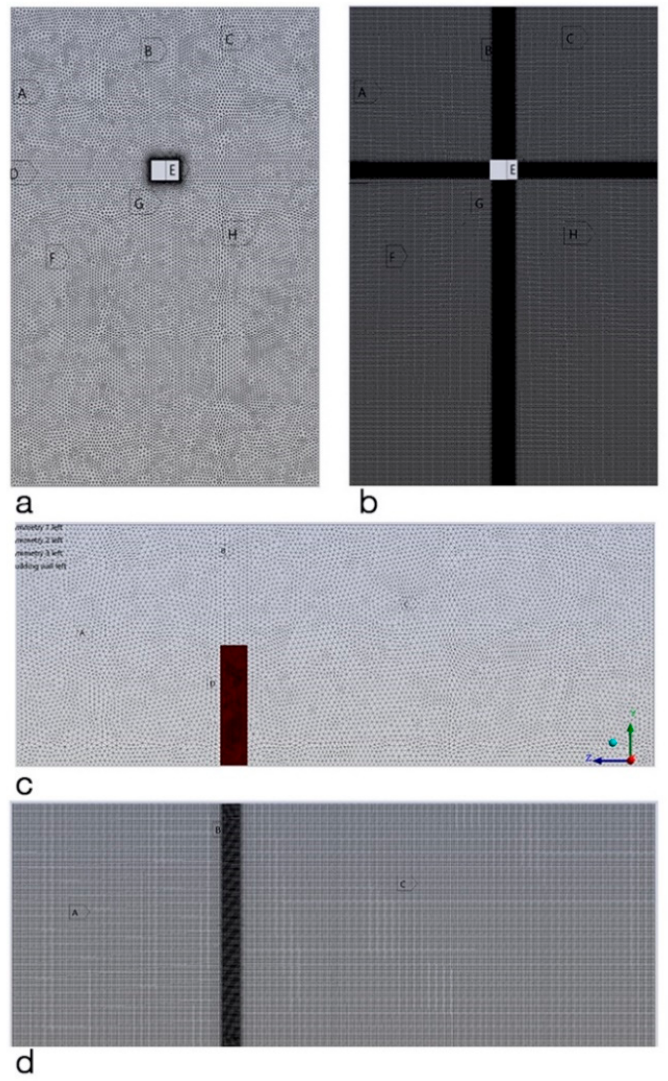
Figure 5. Mesh design; ( a ) unstructured plan view, ( b ) structured plan view, ( c ) unstructured side view, ( d ) structured side view. Table 4. Mesh sizing used for building model validation.